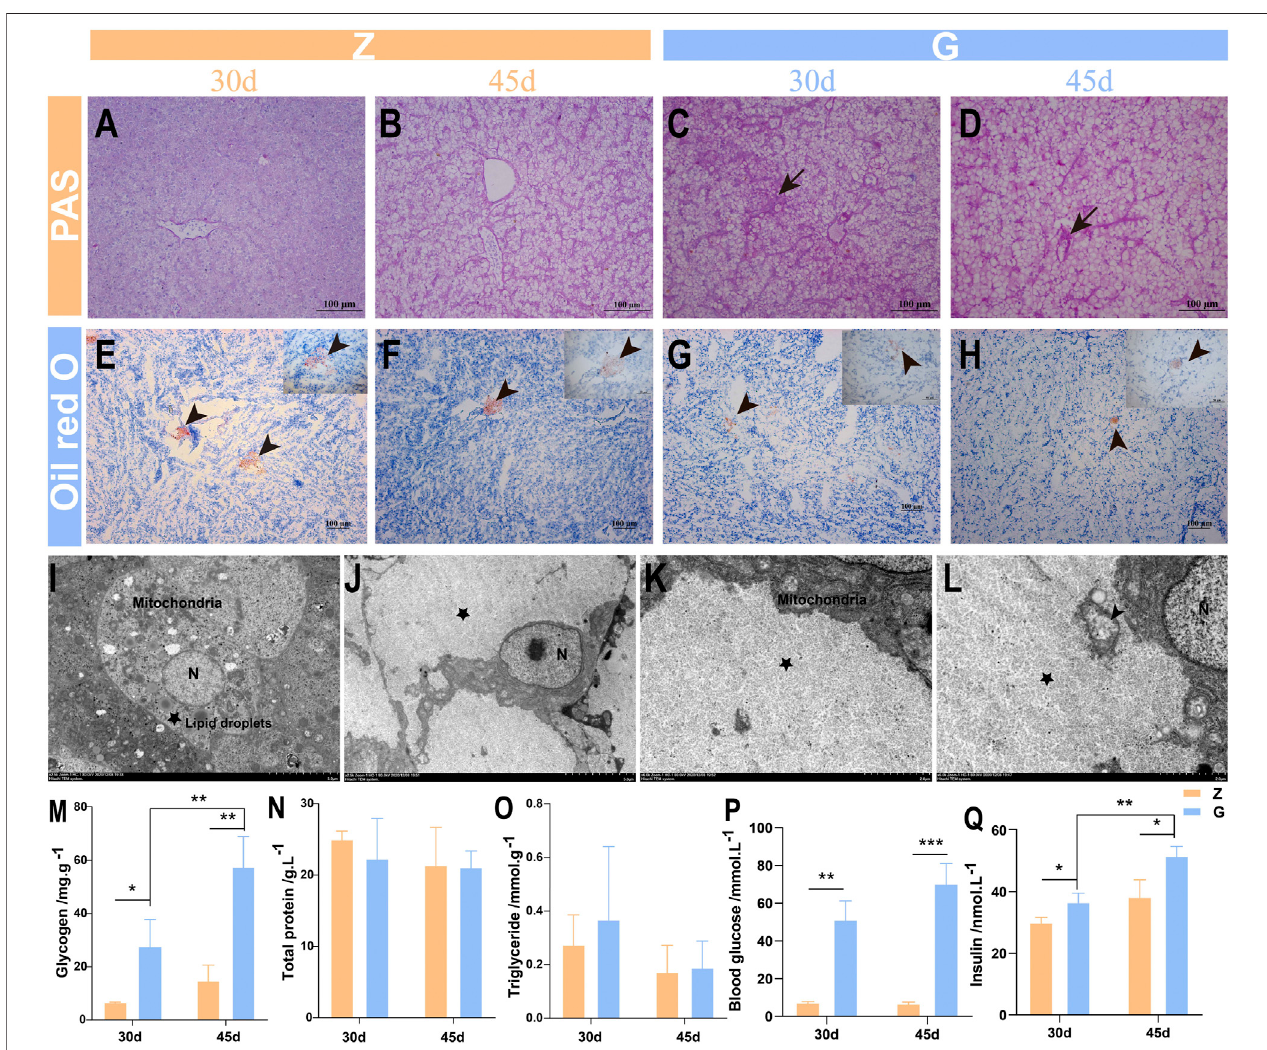
FIGURE 3 | Liver glycogen and fat detection of largemouth bass. (A – D) PAS staining. (A,B) The liver of largemouth bass fed the Z diet for 30 and 45 days, respectively. (C,D) Theliveroflargemouth bassfedtheGdietfor30and 45 days,respectivelyGlycogenaccumulation(arrow). (E – H) OilredOstaining. (E,F) Theliverof largemouth bass fed the Z diet for 30 and 45 days, respectively. (G,H) The liver of largemouth bass fed the G diet for 30 and 45 days, respectively Fat deposition (arrowhead). (I – L) Ultrastructural pathology of the largemouth bass hepatocytes after 45 days of feeding the two diets. (I) Largemouth bass fed the Z diet had an intact hepatocyte morphology with abundant organelles and small amounts of glycogen and lipid droplets deposited. (J – L) Large amounts of glycogen deposition (pentagram), reduced organelles, swollen mitochondria with the break and disappearance of cristae (arrowhead) in the hepatocytes of largemouth bass fed a G diet. (M – O) Glycogen, triglycerides and total protein were determined in the livers of largemouth bass, respectively. (P,Q) Determination of blood glucose and insulin levels in the serum of largemouth bass (* p < 0.05, ** p < 0.01, and *** p <